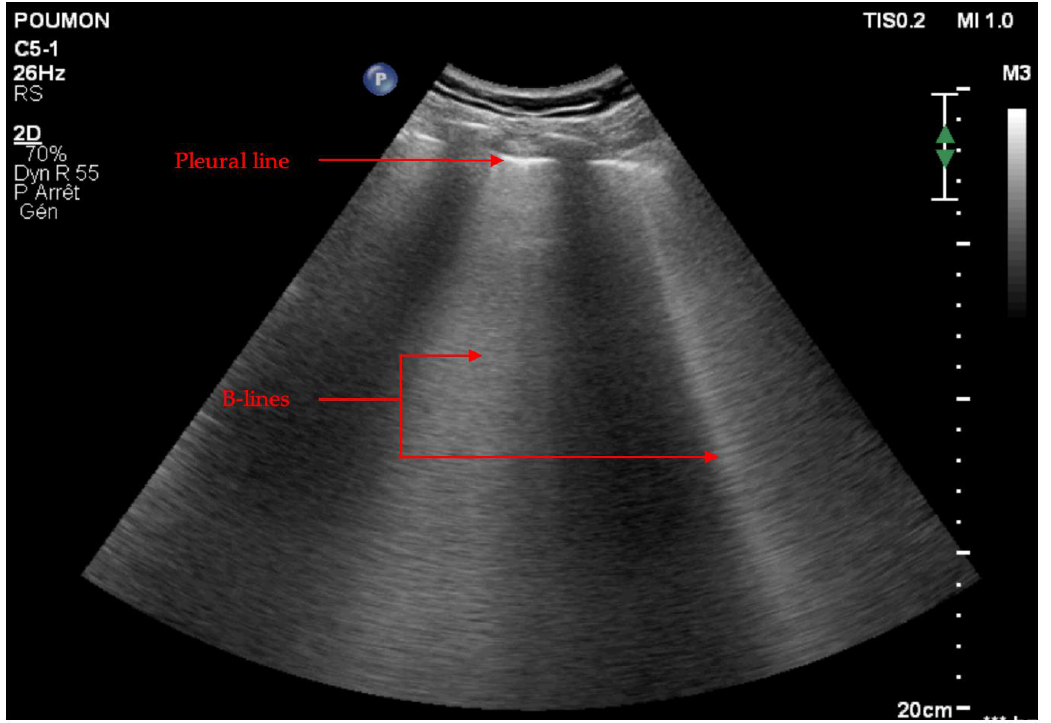
Figure 9. B-lines. B-lines appear as vertical hyperechoic line artefacts taking the whole height of the screen crossing the A-lines without decreasing in intensity. B-lines always arising from the pleural line and moving simultaneously with lung sliding and normal lungs can demonstrate up to three B-lines per lung window/intercostal space.